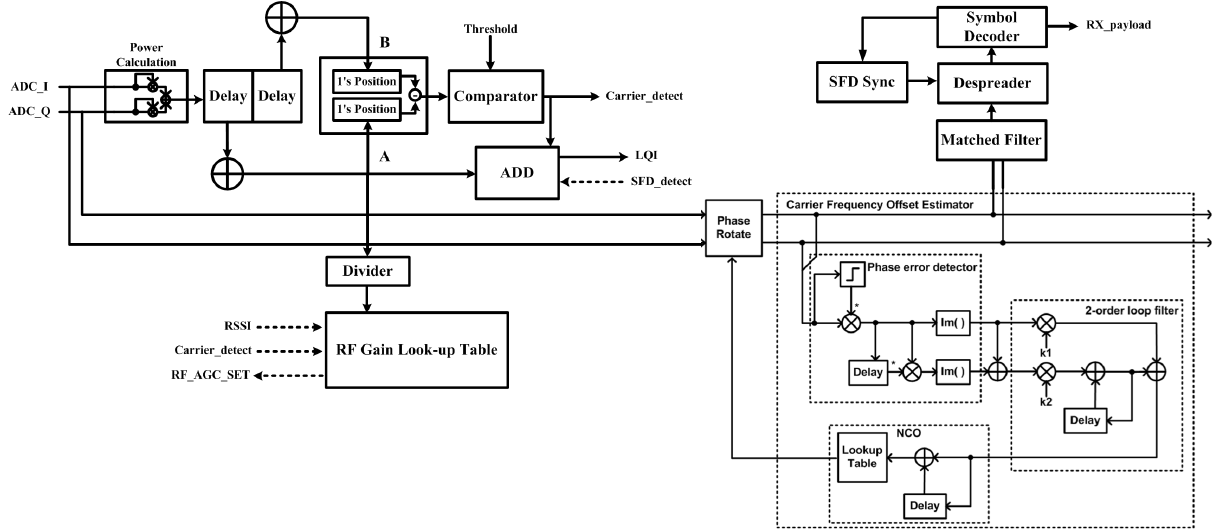
Figure 6. Synchronization block for digital